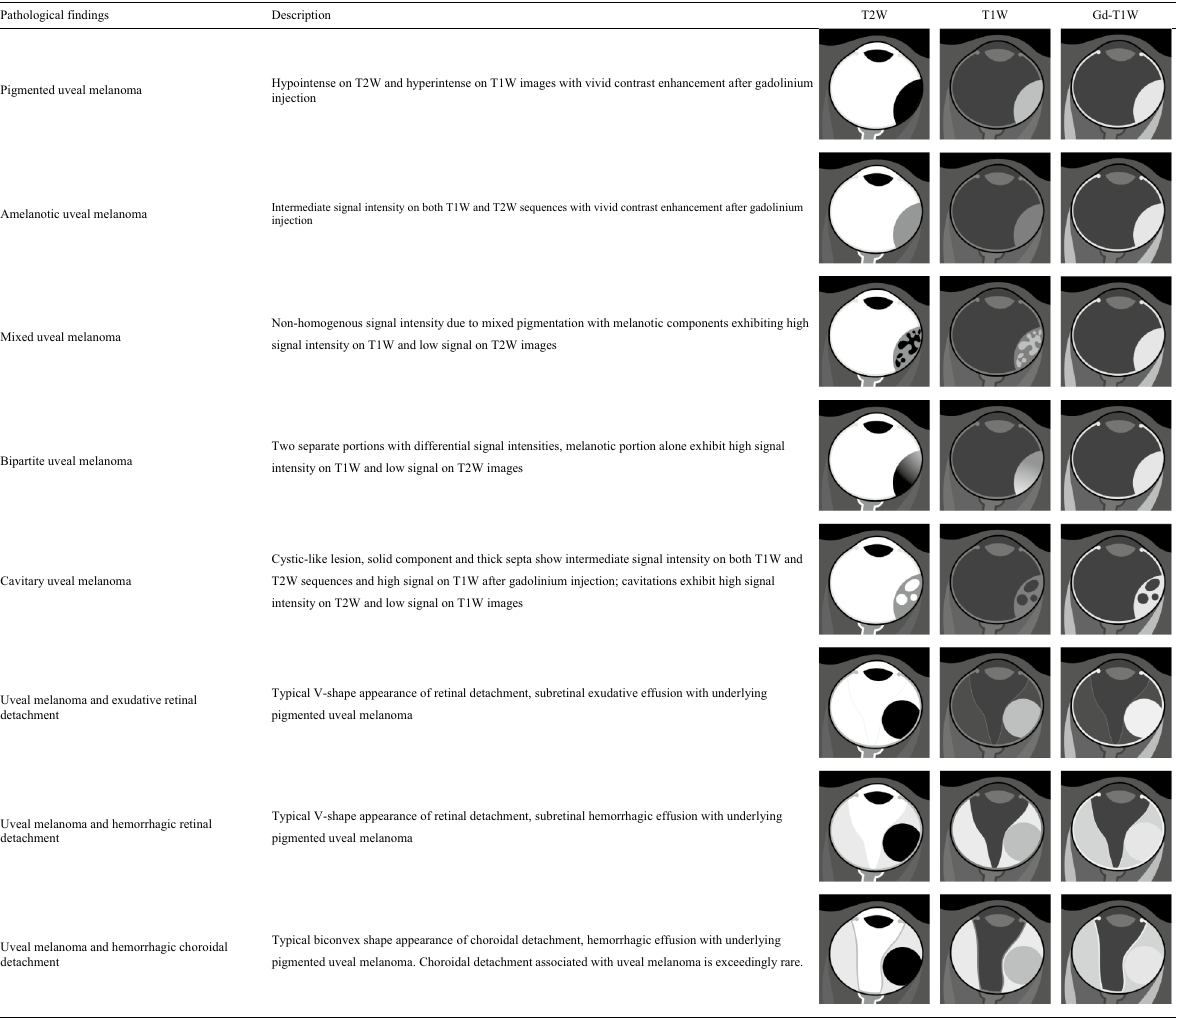
Table 4 Chart summarizing MR imaging features of the different variants of uveal melanoma, retinal and choroidal detachment Pathological